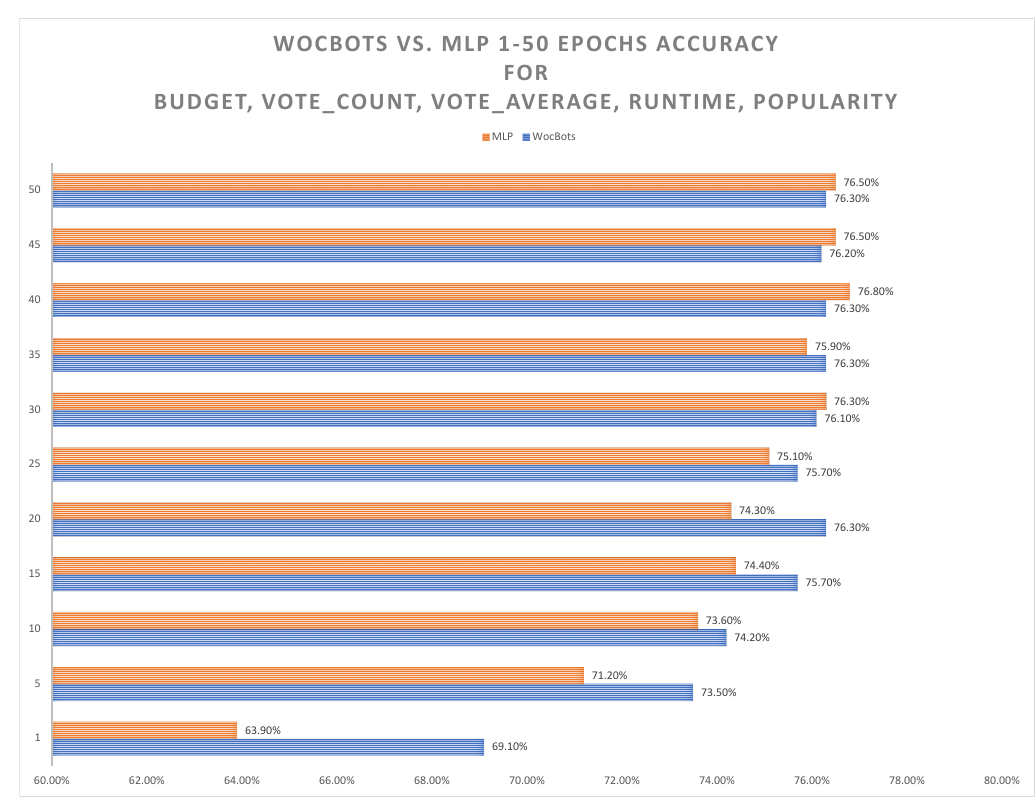
Figure 4. Accuracy of MLP and WoC-Bots for five features over 1–50